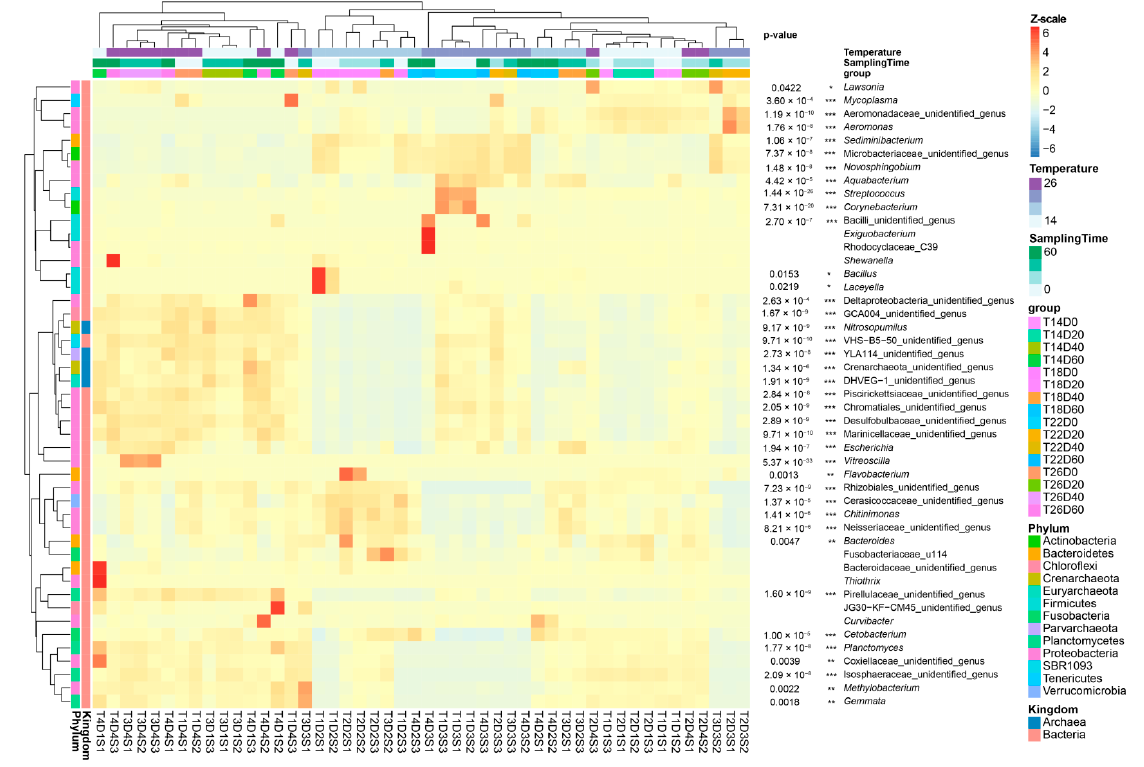
Figure 5. Heatmap profile of dominant genera of Percocypris pingi gut microbiota at different culture temperatures. * p < 0.05; ** p < 0.01; *** p <